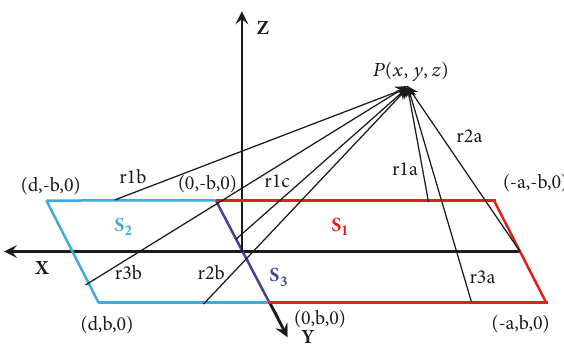
Figure 4: Double loop presented in three